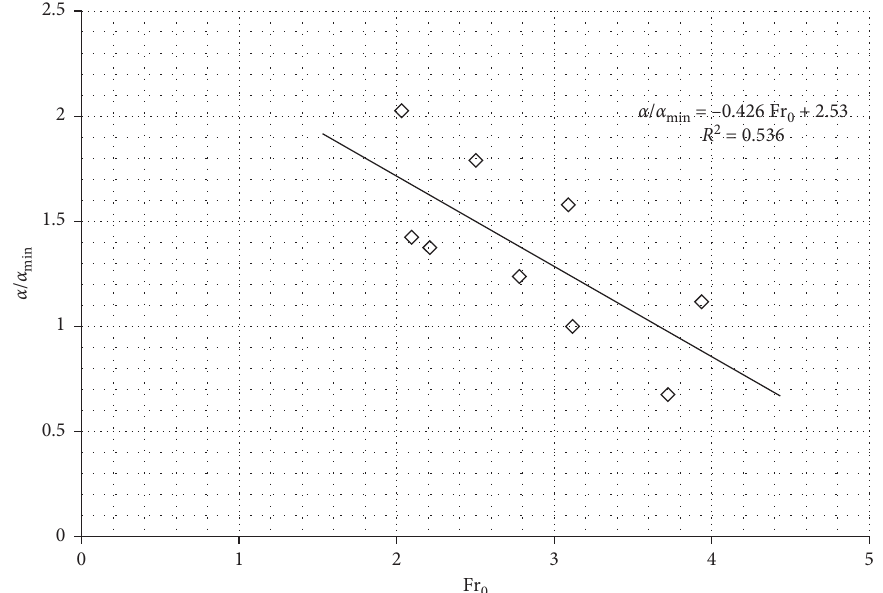
Figure 16: Dimensionless curves of the wave formation angle variation in terms of the Froude number.